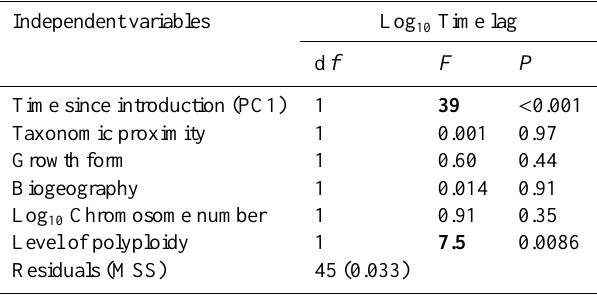
Table 2. E ff ects of time since introduction, taxonomic proximity, growth form, biogeography, chromosome number and polyploidy on the time lag. The table shows the results of a linear model. The time lag and the chromosome number were log 10 -transformed be- fore analyses. Significant F-values ( P ≤ 0.05) are printed in bold ( n = 52). Recoding the level of polyploidization to a factors with two levels (yes / no) leads to almost the same results (for the factor polyploidization F = 6 . 6; P = 0 .